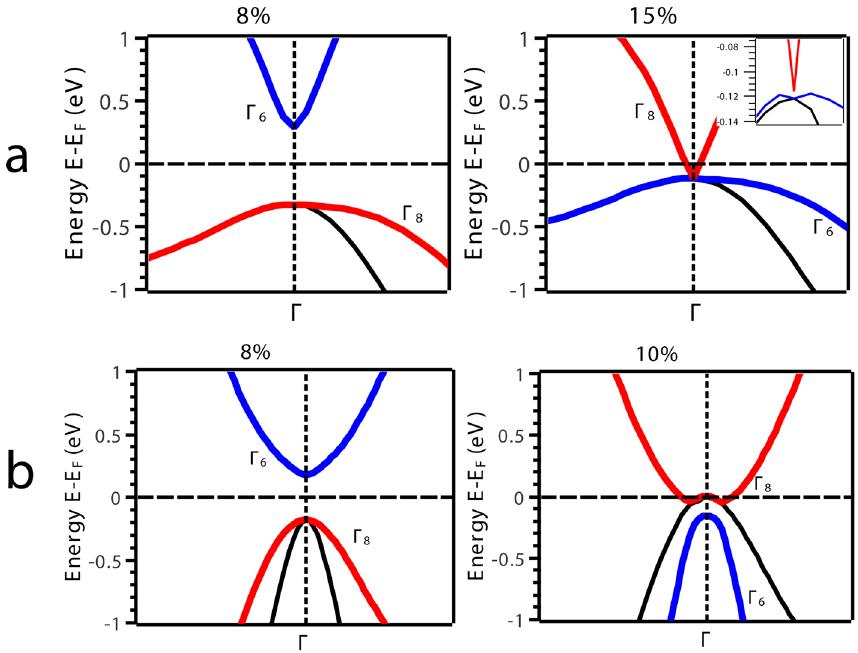
Figure 4. Electronic Band Structure (EBS) in the vicinity of Fermi level indicating the closing of band gap with band inversion in ( a ) bulk (inset, opening of the gap at 17% VEP) and ( b ) low-dimensional [111] phase of LiMgAs.